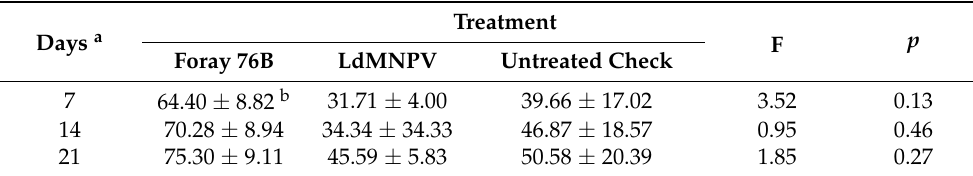
Table 3. Percentage (mean ± SE) of larval density reduction in the field at different time intervals after bioinsecticidal application, in respect to pre-treatment. Percentage data are corrected using the Schneider-Orelli